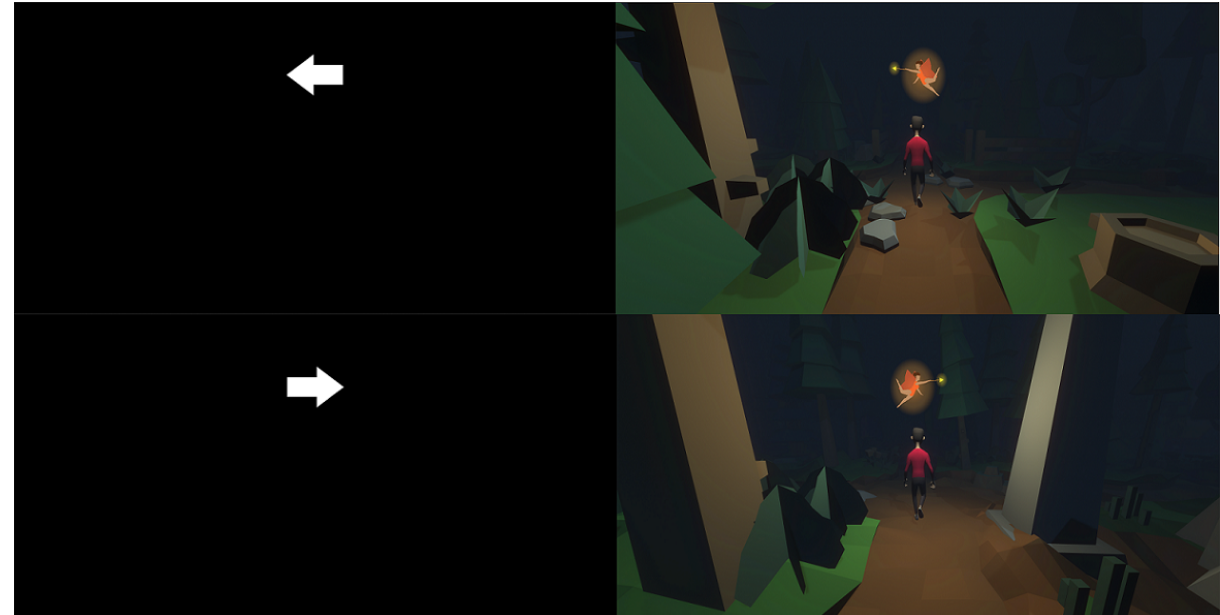
Figure 1. The stop-signal task (left) vs stop-signal game (right) trial